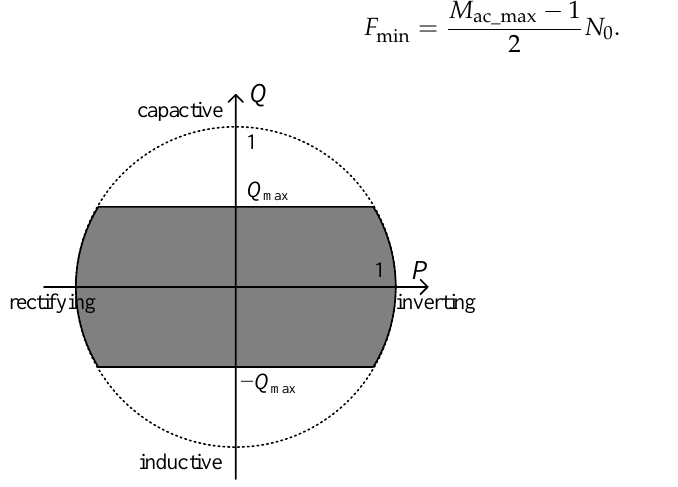
Figure 4. P / Q operating region of MMC considering maximum reactive power